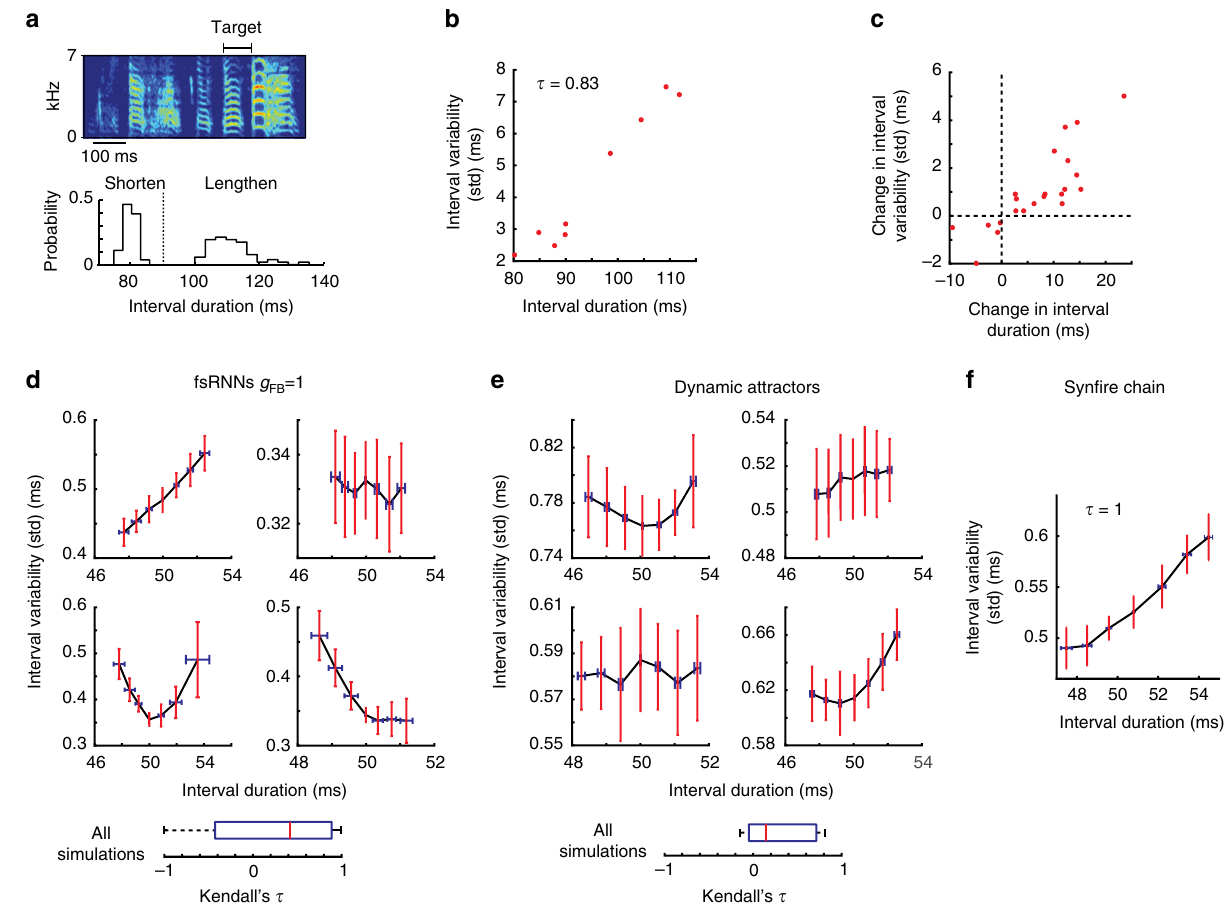
Fig. 6 Changes in temporal variability with learning. a (Top) Spectrogram of a zebra fi nch song showing the target segment. (Bottom) Histograms of mean durations of a target segment after it had been shortened and lengthened using our CAF paradigm. Mean at baseline is denoted by dotted line. b Scatterplot of variability (standard deviation) as a function of mean segment duration for the same example as in a across 9 days of CAF (Kendall ’ s τ = 0.83, p = 8.5 × 10 − 4 , n = 9 days). c Scatterplot of change in variability (standard deviation) as a function of change in mean segment duration (both relative to baseline before CAF). d Standard deviation of target duration as a function of the target ’ s mean duration for fsRNNs with g FB = 1. For this value of feedback, the temporal variability is consistent with variability observed in zebra fi nch song (see the discussion in Methods). Target intervals were lengthened and shortened from baseline for 3000 trials each. Data from 200 ‘ catch ’ (i.e., non-reinforced) trials interspersed between every 1000 trials, averaged across 20 simulations. Example from four fsRNNs are shown. Error bars are standard deviations across simulations. (Bottom) Box plot of all Kendall ’ s τ coef fi cients between interval variability and interval duration, across 20 networks, 2 target intervals each (3rd and 8th). e Same as d for dynamic attractor networks. Box plot of all Kendall ’ s τ coef fi cients across 14 networks, 1 target interval each (3rd). f Same as d , but for syn fi re chains. Data from 200 ‘ catch ’ trials interspersed between every 1000 trials, averaged across 20 simulations. Target interval: